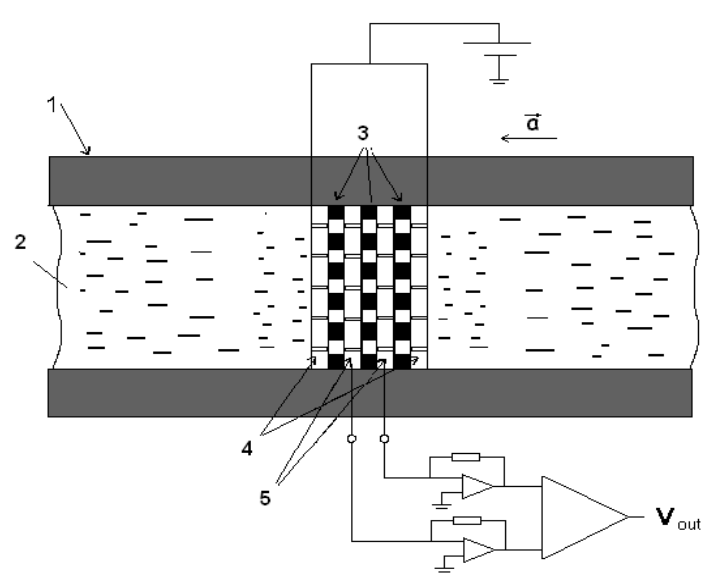
Figure 1. Molecular electronic transducer. 1: dielectric pipe; 2: electrolyte; 3: porous ceramic spacers; 4: anodes; 5: cathodes; a: external mechanical acceleration; v out : output signal.